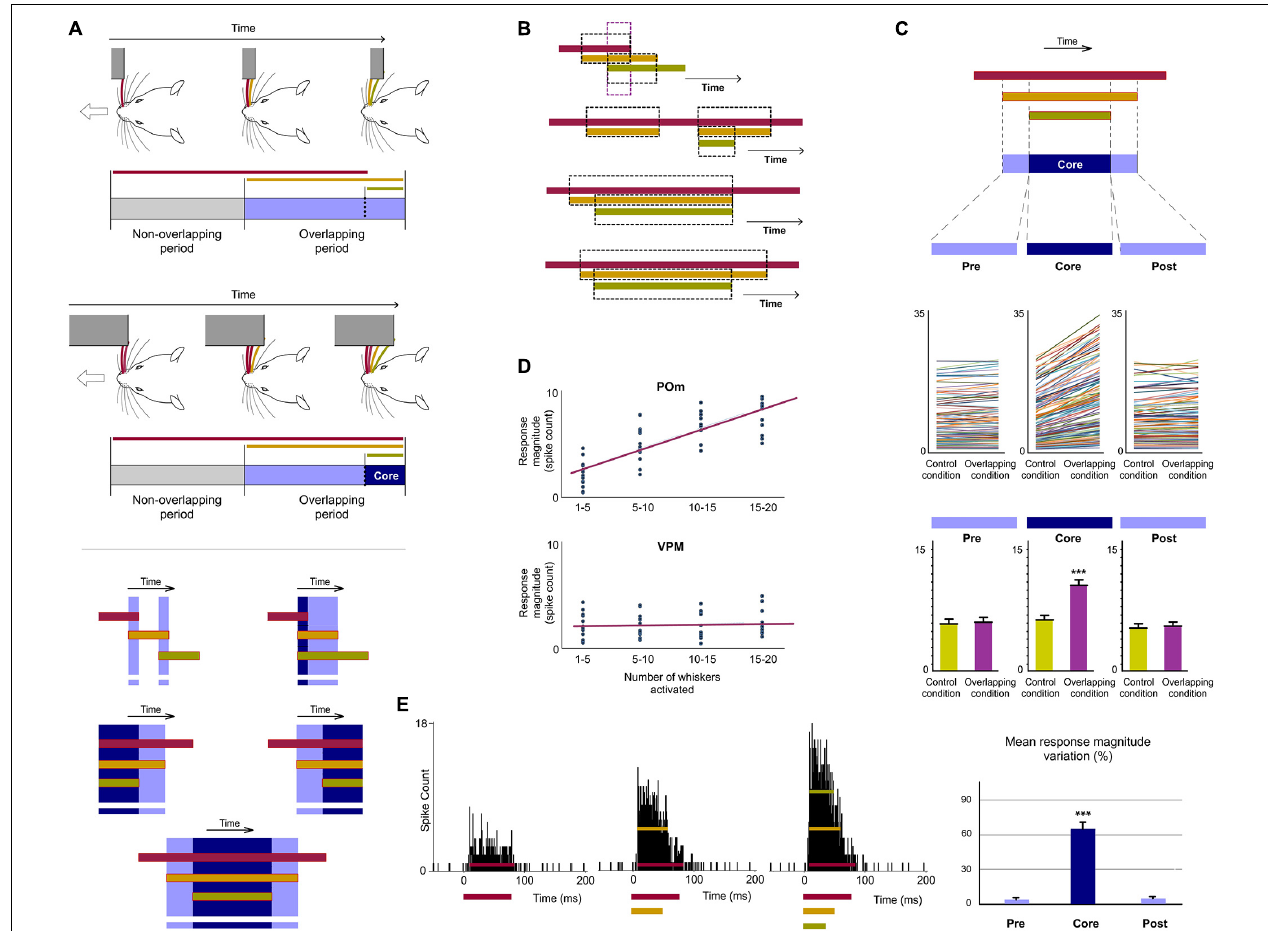
FIGURE 5 | POm is highly sensitive to the dynamical spatiotemporal structure of sensory patterns and to the variability of their parts. (A) Multiple and constantly changing overlappings occur dynamically during contacts with objects and surfaces during active exploration. Accordingly, the number of whiskers implicated is constantly changing. As can be appreciated in these schematic illustrations of two simulated tactile sequences, their Overlapping periods are different. Defined by the number of whiskers simultaneously activated, “simple” overlappings (in light blue) and more “complex” overlappings (in dark blue) were used to understand how POm codifies this variability (bottom panel). The parts of the Overlapping periods with the mayor number of whiskers were selected and defined as “Core” parts. (B) Spatiotemporal patterns produced by the simultaneous application of a third air puff activating additional whiskers. Different spatiotemporal overlappings were generated by varying the onset and duration of the third air puff and the number of extra whiskers stimulated by this air puff. (C) POm responses during Overlapping periods were divided in three subperiods (Pre, Core, and Post). They were compared before (Control condition) and after the application of the third air puff (Overlapping condition). Data comparing the spike rate of all recorded multi-units ( n = 101, depicted in different colors) in these conditions during Pre, Core, and Post subperiods across sensory patterns and the total mean response magnitude in both conditions in these subperiods are described. The mean firing rate was increased in the Core subperiod ( p < 0.001; Wilcoxon matched-pairs test) but not in the Pre ( p = 0.63; Wilcoxon matched-pairs test) and Post ( p = 0.74; Wilcoxon matched-pairs test) subperiods. (D) Correlation between POm response magnitude and the number of whiskers simultaneously overlapped. Data from VPM are also shown for comparison. POm: Pearson correlation coefficient, r = 0.79, p < 0.001, n = 51 multi-units in 10 rats; VPM: r = 0.19, p < 0.001, n = 45 multi-units in 8 rats. The number of whiskers simultaneously activated is computed by POm. Note the profound functional difference between these nuclei. (E) PSTHs for